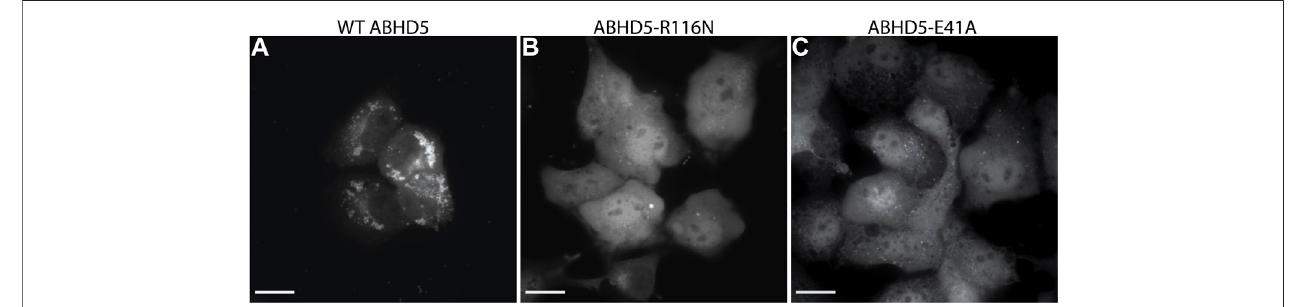
FIGURE3| Fluorescence imagingrevealstheimportance ofR116andE41 inthebasallocalizationofABHD5. (A) Wild-type (WT) ABHD5-mCherrylocalizestothe LDs within COS7 cells. Either the (B) R116N or (C) E41A mutations demonstrate a cytosolic distribution of ABHD5-mCherry and inhibited basal LD targeting in the absence of ATGL and PLIN5 expression. (A – C) The scale bars represent 20 µm.